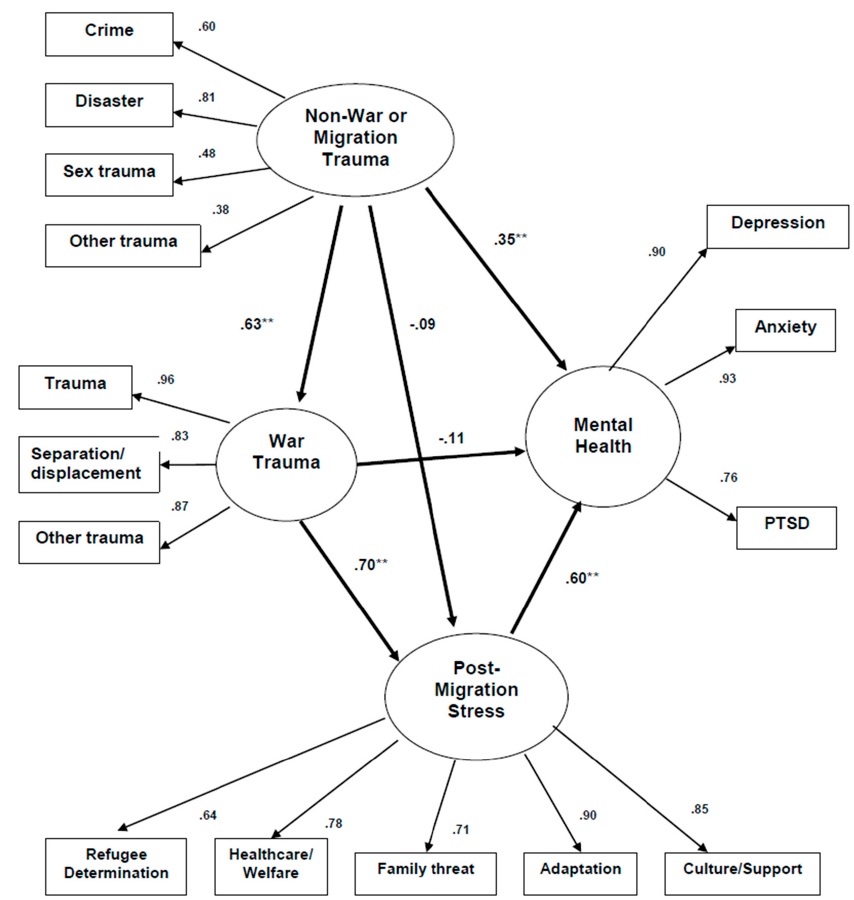
Figure 1. Predicting Mental Health from Various Sources of Trauma: Kurdish ( N = 117, Standardized Regression Weights and Factor Loadings). ** P < 0.01; Full Model: χ 2 = 157.9, DF = 84, p < 0.001, RMR = 1.44, GFI = 0.93, AGFI = 0.90.